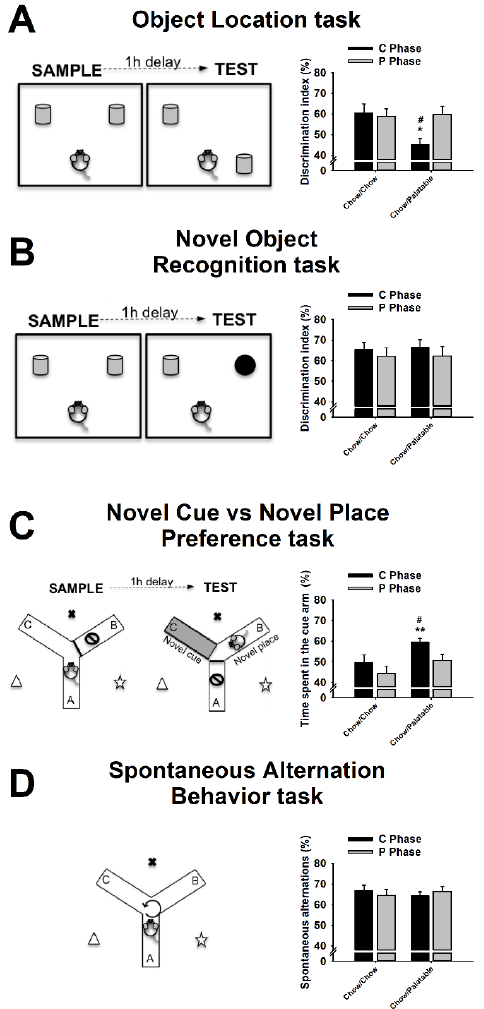
Figure 2. Effects of repeated, alternating 5 ‐ day access to chow and 2 ‐ day access to either regular chow Figure 2. E ff ects of repeated, alternating 5-day access to chow and 2-day access to either regular (Chow/Chow) or a palatable diet (Chow/Palatable) in male Wistar rats on (A) Object Place chow (Chow / Chow) or a palatable diet (Chow / Palatable) in male Wistar rats on ( A ) Object Place Recognition task; (B) Novel Cue vs. Novel Place Preference task; (C) Spontaneous alternation task; Recognition task; ( B ) Novel Cue vs. Novel Place Preference task; ( C ) Spontaneous alternation task; (D) Object Recognition task ( n =8–10/group). Data show M ±SEM. # p ≤ 0.05, Chow/Palatable in C phase ( D ) Object Recognition task ( n = 8–10 / group). Data show M ± SEM. # p ≤ 0.05, Chow / Palatable in C vs. Chow/Palatable in P phase; * p ≤ 0.05, ** p ≤ 0.01 Chow/Palatable in C phase vs. Chow/Chow in C phase vs. Chow / Palatable in P phase; * p ≤ 0.05, ** p ≤ 0.01 Chow / Palatable in C phase vs. Chow / Chow phase. in C